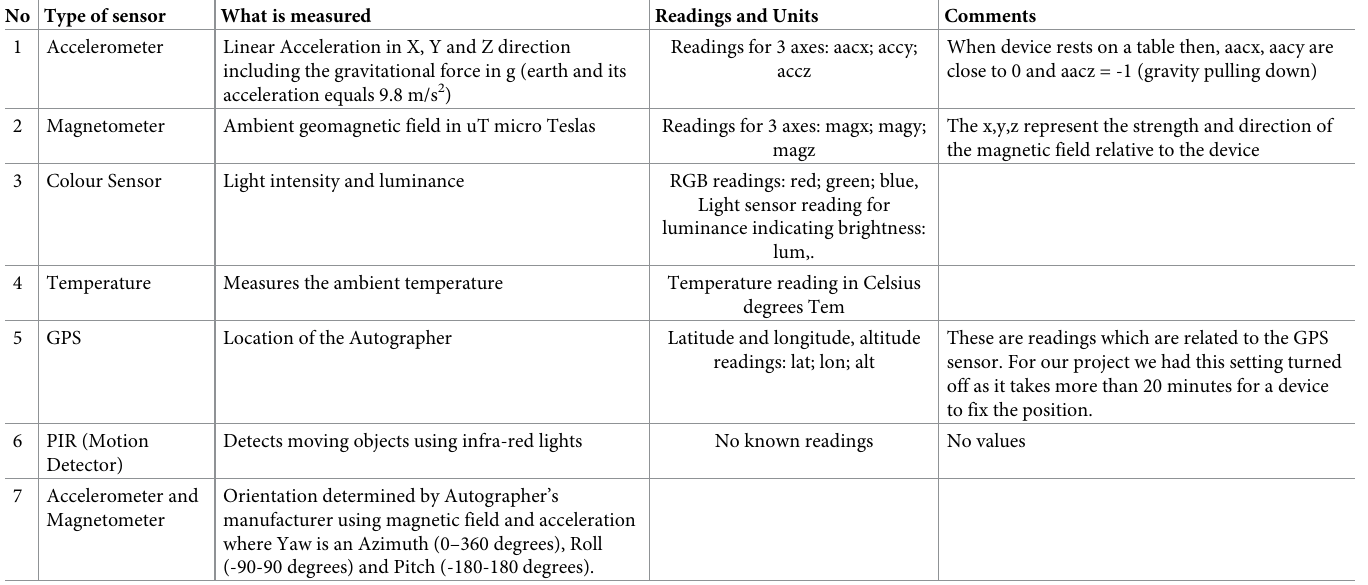
Table 1. Types of Autographer’s sensors, measurements and measurements’